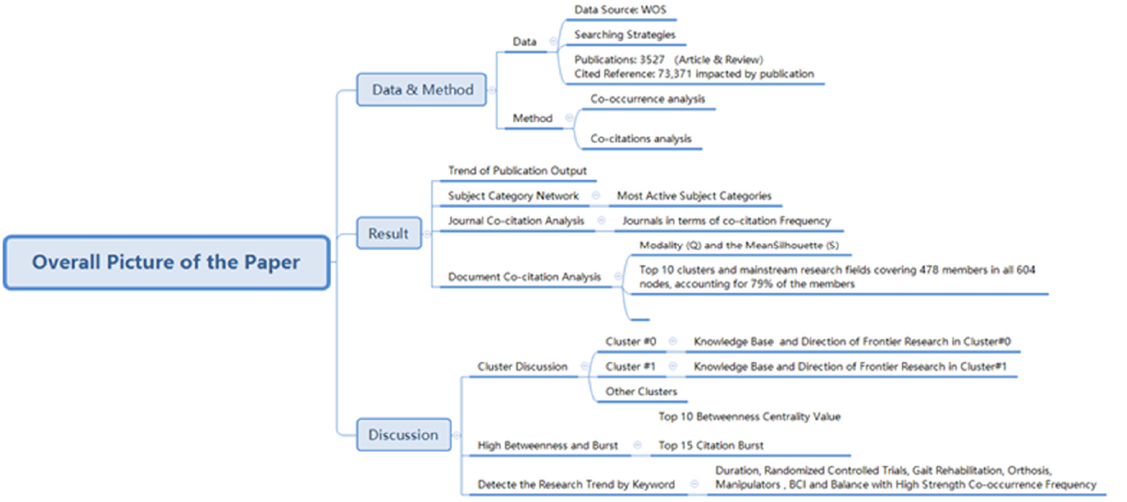
Figure 7 . Overall picture of this